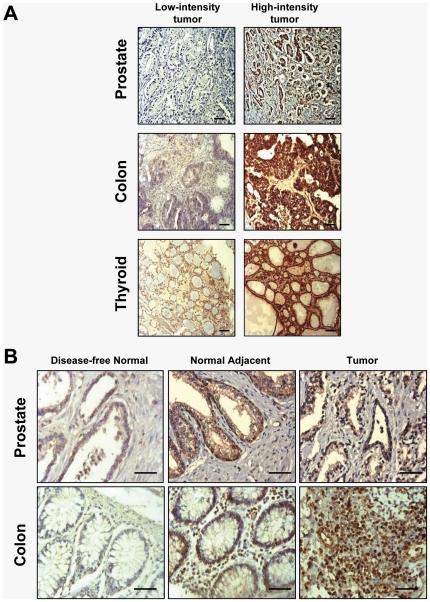
Immunohistochemical staining for LEDGF/p75 protein in selected human tumors.A. Representative images of immunohistochemical staining (low intensity, scores 0–1; high intensity, scores 2–3) for LEDGF/p75 in prostate, colon, and thyroid tumors (Scale bar-40 µm; magnification = 200×). B. Representative images of LEDGF/p75 immunostaining of non-disease normal prostate and colon tissues, and in tumor tissues and their matched adjacent tissues (Scale bar-40 µm; magnification = 400×). TMAs were stained using LEDGF/p75 specific rabbit antibody Scripps-Ab5087, as indicated in Materials and Methods. Identical camera settings were used in the acquisition and processing of images for a particular tissue type.